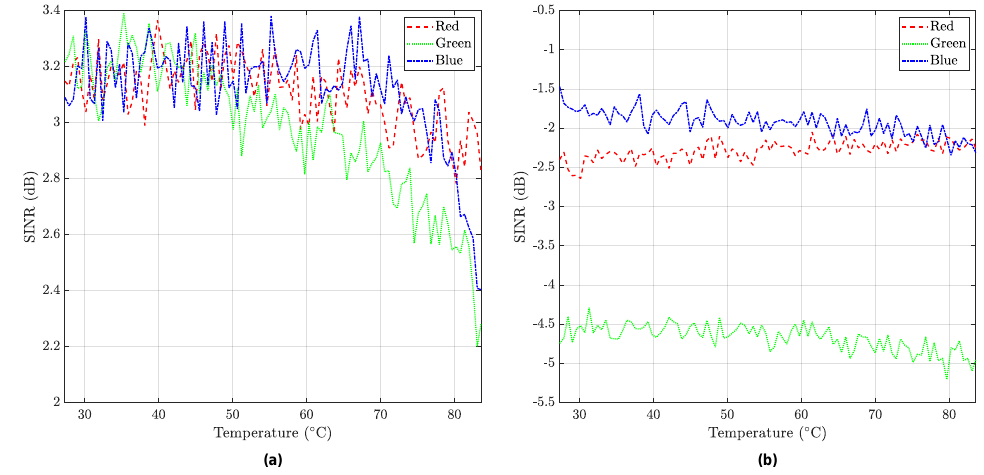
Figure 16. SINR at different temperatures, compensating the channel using the CSI corresponding to 60°C and with a low SNR value (10 dB). ( a ) Sony IMX249 and ( b ) Foveon X3. Dashed line, dotted line, and dash-dot line correspond to red, green, and blue,